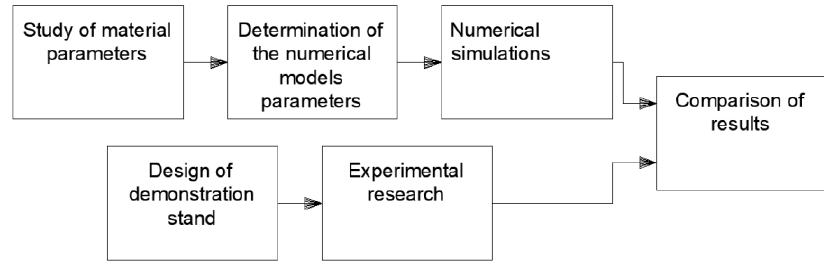
Figure 2. Stages of the overall research project.